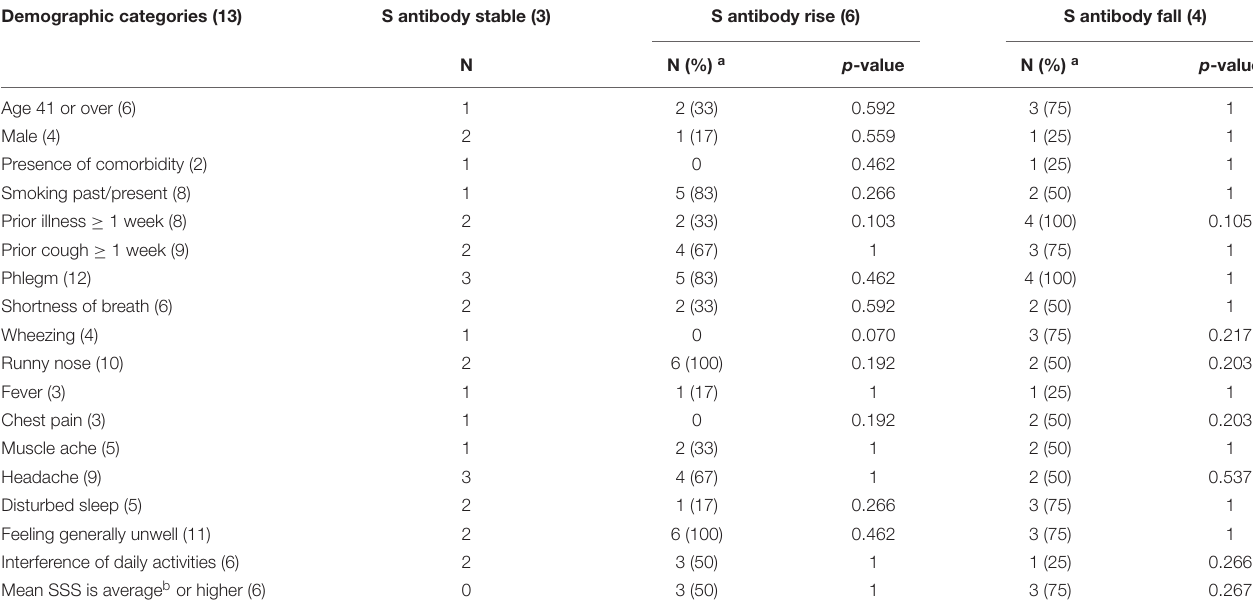
TABLE 3 | Association between demographic categories and S-antibody dynamics in HCoV-HKU1-infected symptoms. Demographic categories